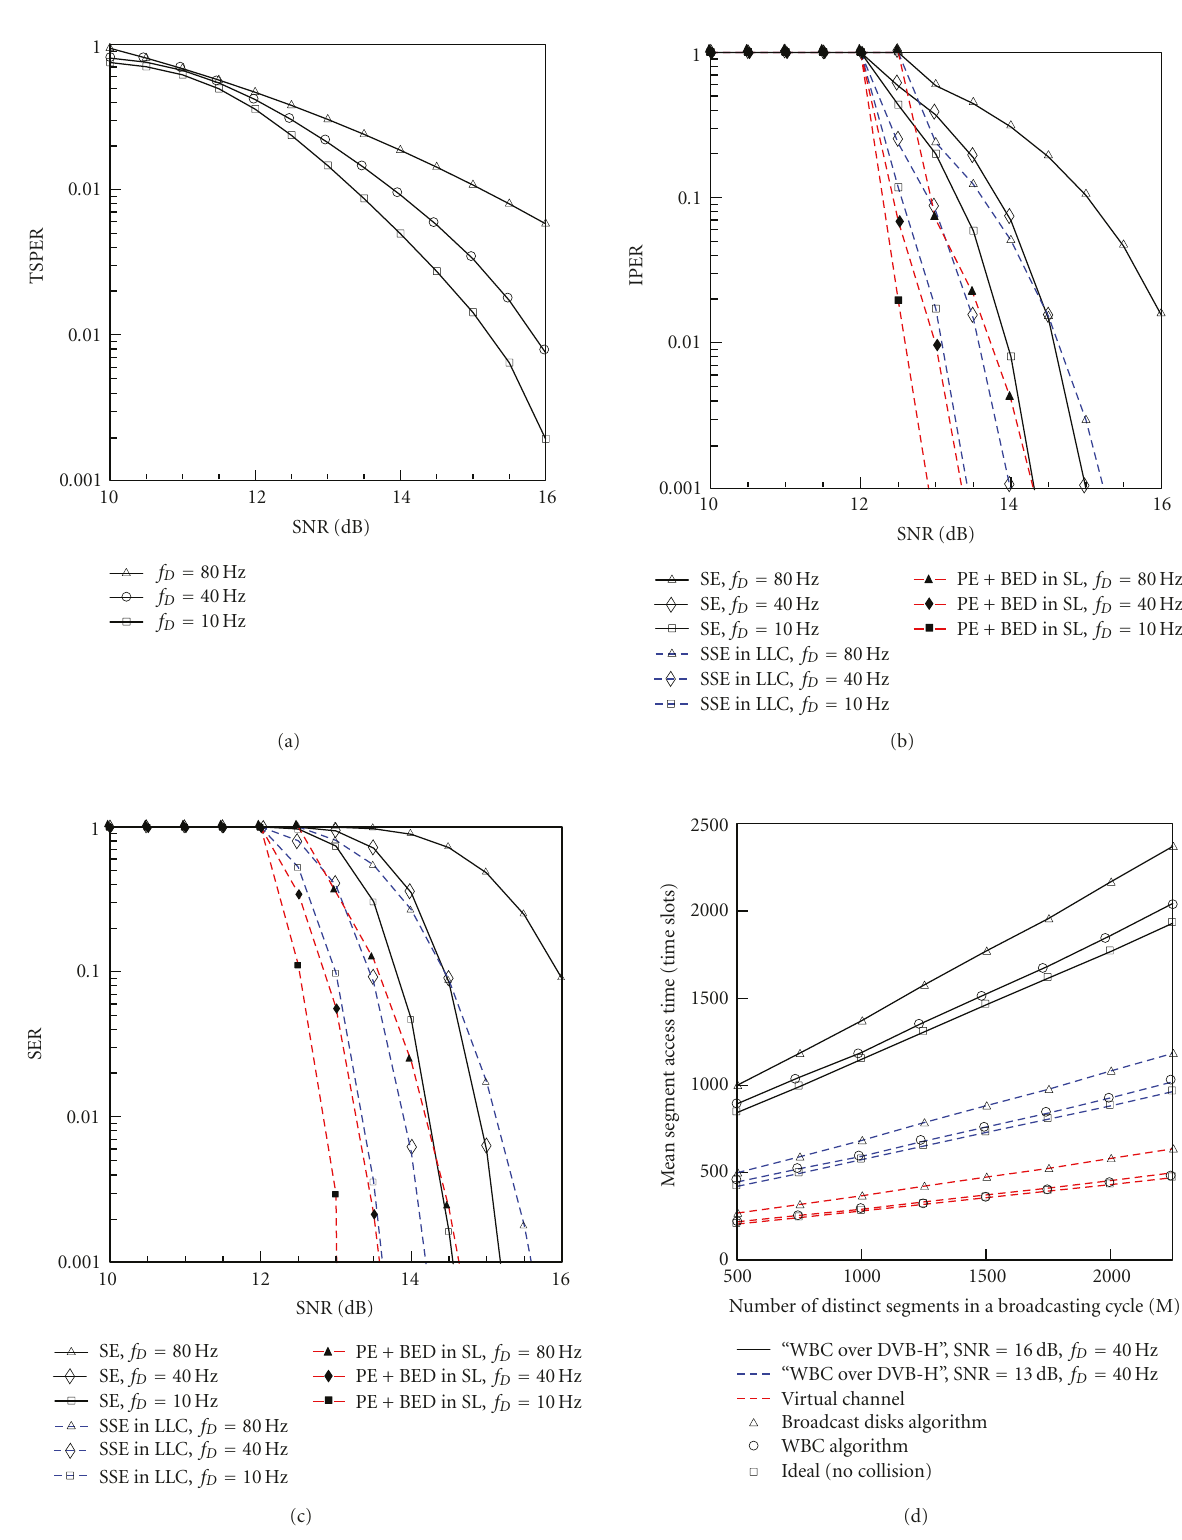
Figure 13: The “WBC over DVB-H” performance simulation results: (a) TSPER; (b) IPER; (c) SER; (d) mean segment access